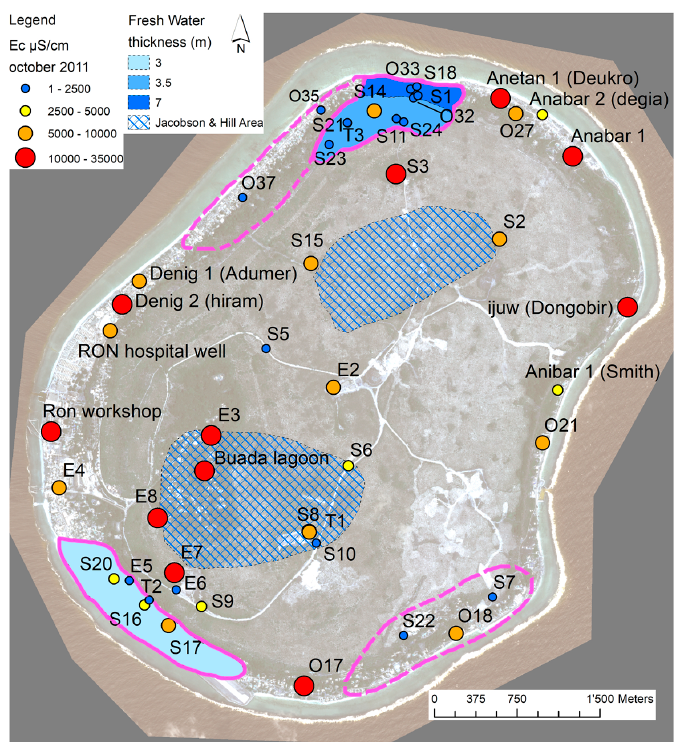
Figure 13. Results of the EC survey in monitoring wells and private wells (October 2011). Pink line indicates the most suitable areas for groundwater exploitation and the pink dashed one the potential suitable areas.